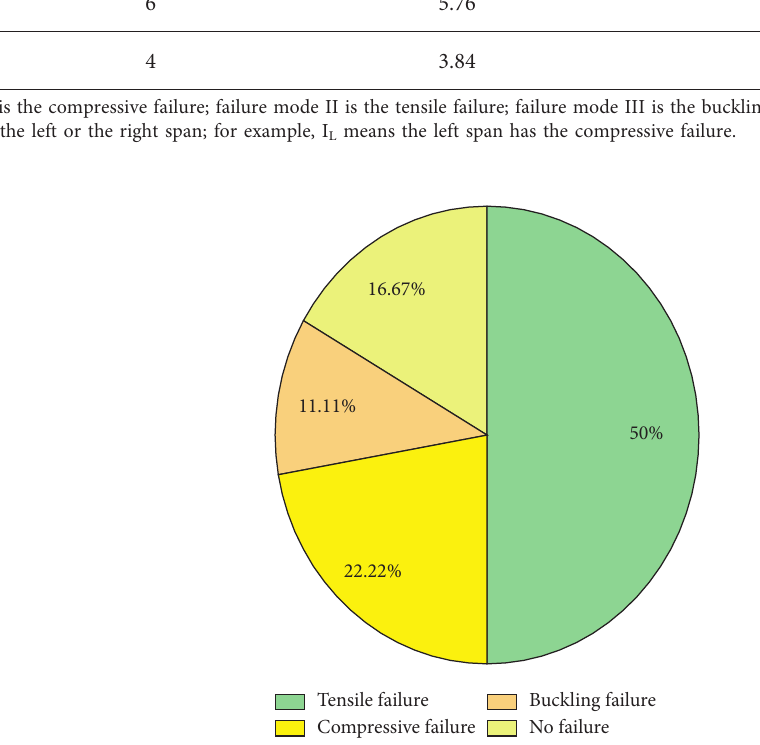
Figure 9: Distribution of failure types of continuous